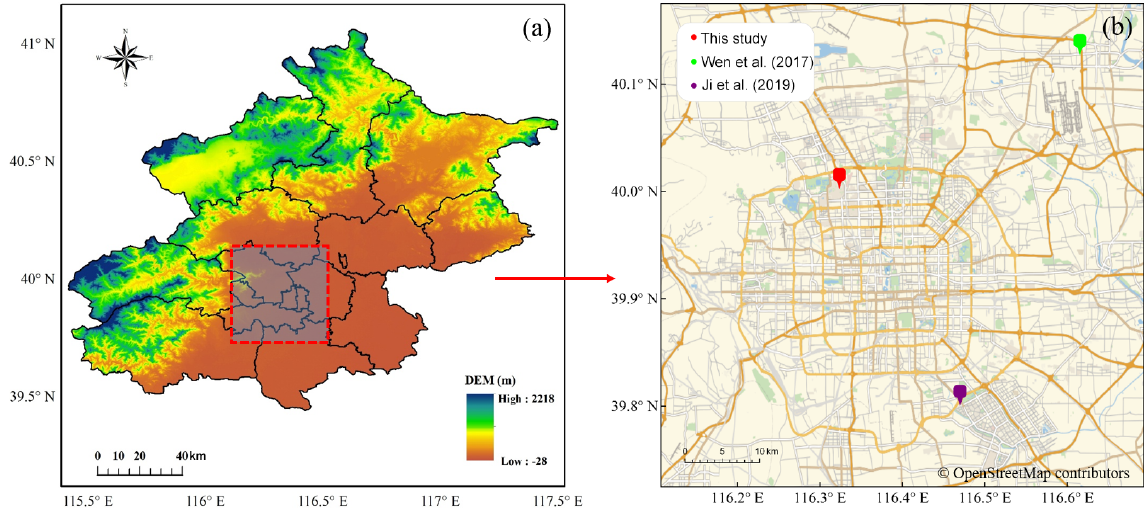
Figure 1. (a) The topography of Beijing and (b) the locations of DSD studies in the Beijing area; the red mark represents the location of the Parsivel 2 disdrometer deployed at Tsinghua University campus in this study and the green and purple makers represent locations in the studies by G. Wen et al. (2017) and Ji et al. (2019), respectively. The map data are available under the Open Database License. © OpenStreetMap contributors 2019. Distributed under a Creative Commons BY-SA